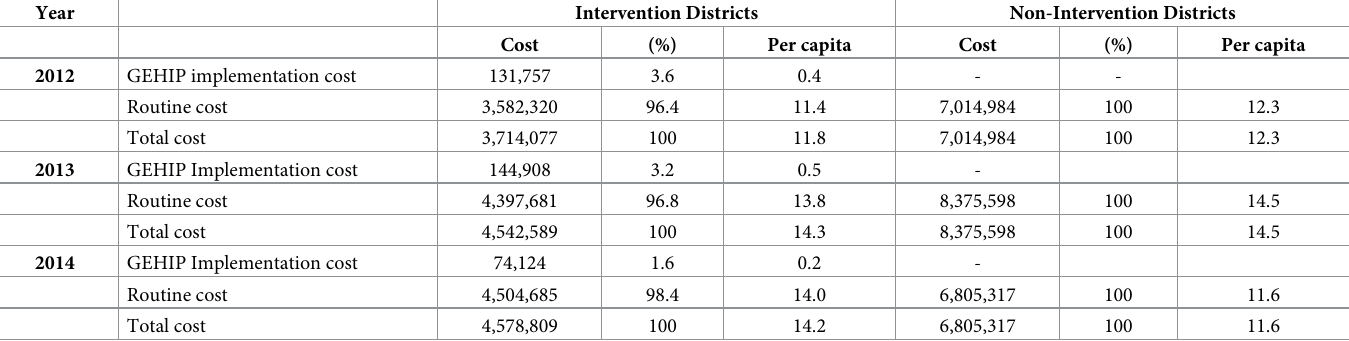
Table 5. Economic cost by intervention and non-intervention districts